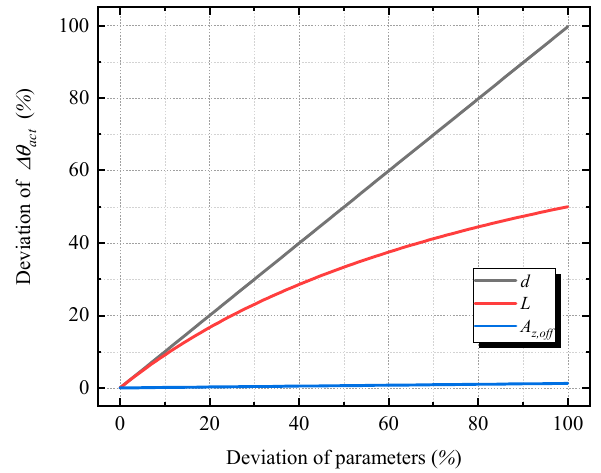
Figure 10. The deviation e ff ects of parameters ( d , L , and A z , of f ) on the calibrated relative